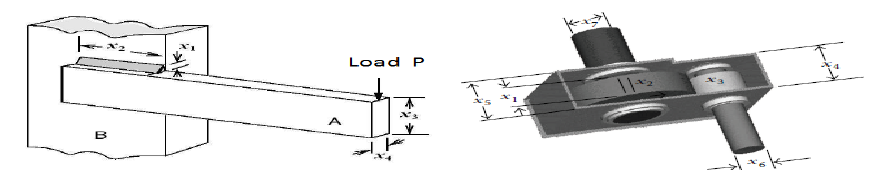
Figure 9. Design engineering problems (Engp3 and Engp4 ).